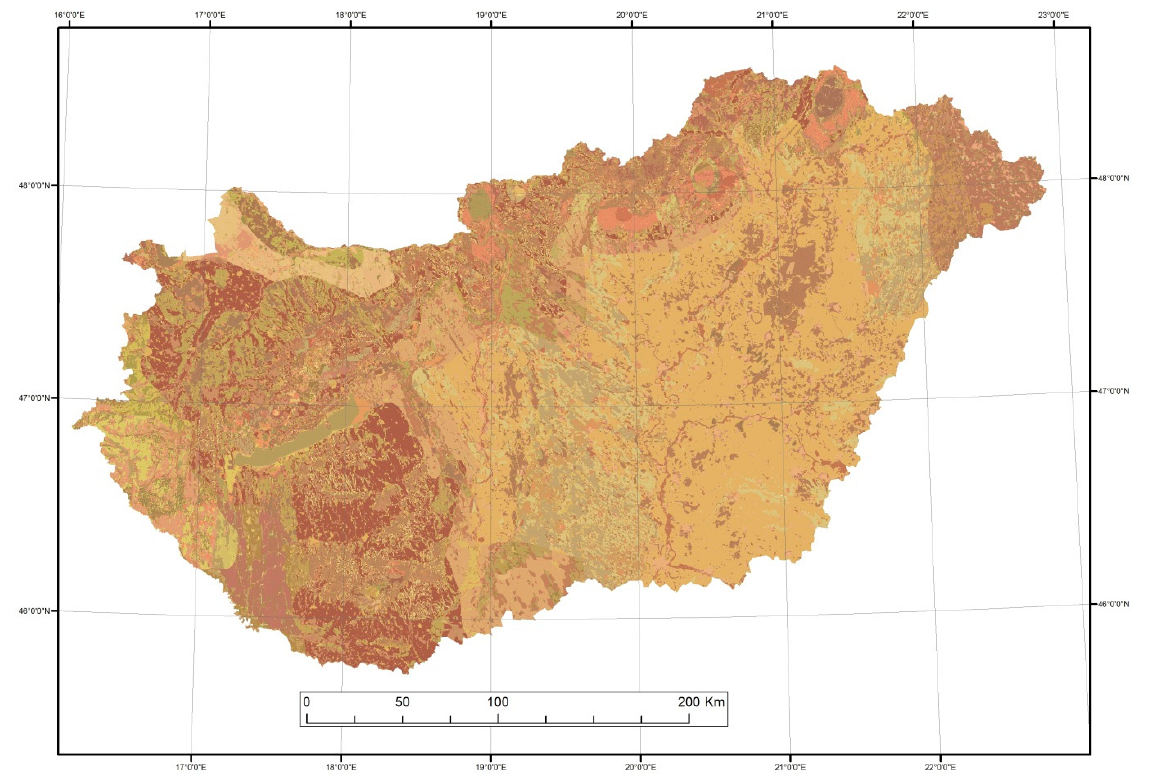
Figure 7. Applied recharge zones delineated as a superposition of four data layers including climate zones, surface geology, landuse, and slope conditions. Different shades indicate different recharge characteristics.